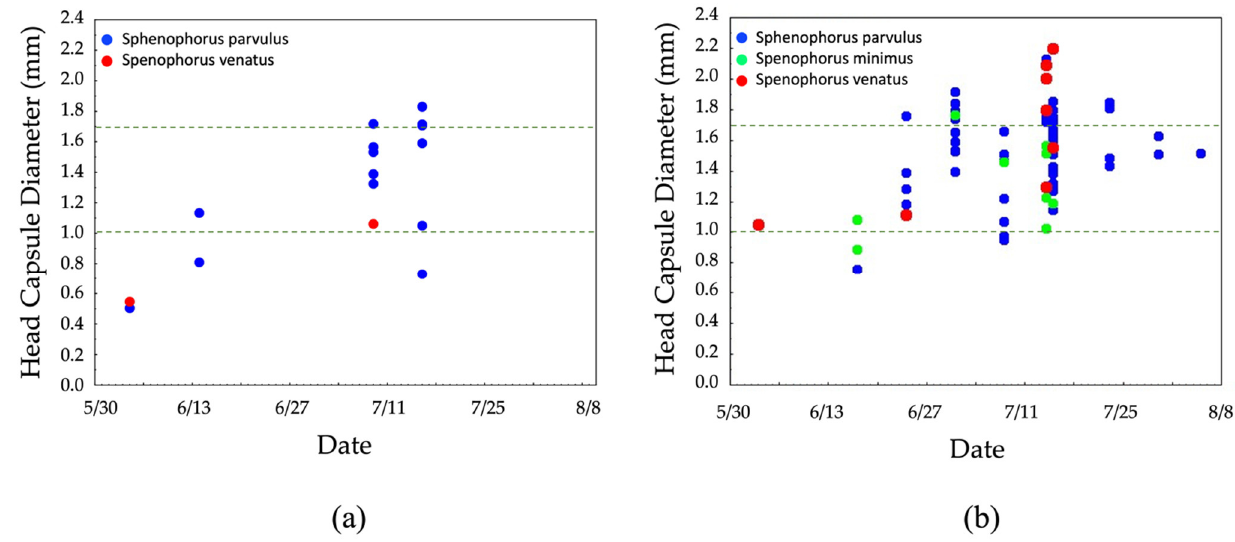
Figure 7. Seasonal phenology charts of billbug larvae collected from ( a ) Utah 2018 and ( b ) Indiana 2020. We adopted the approach of previous studies [17,19] binned larvae as small (head capsule diameter < 1.0 mm of), medium (1.0–1.7 mm), or large (above 1.7 mm).